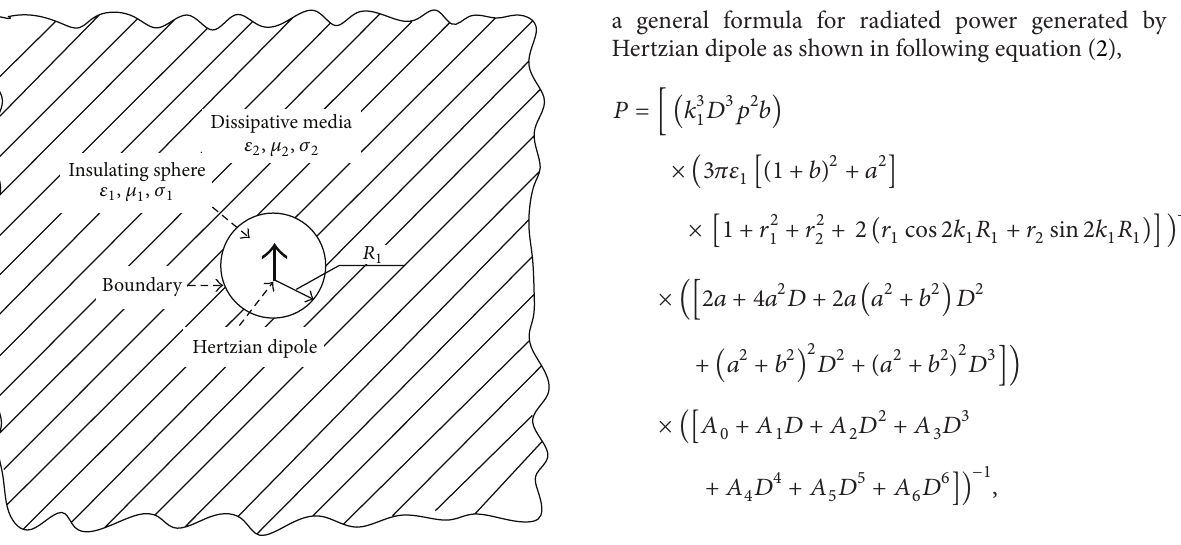
Figure 1: An insulated dipole in a lossy